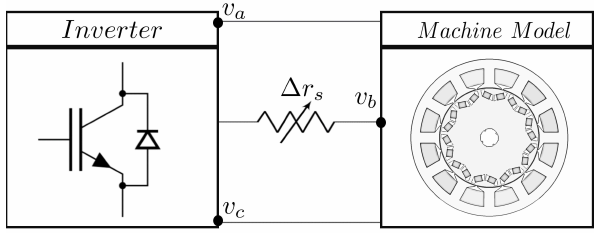
Figure 6. Electrical model of inverter-driven PMSM with HRC fault in phase B.